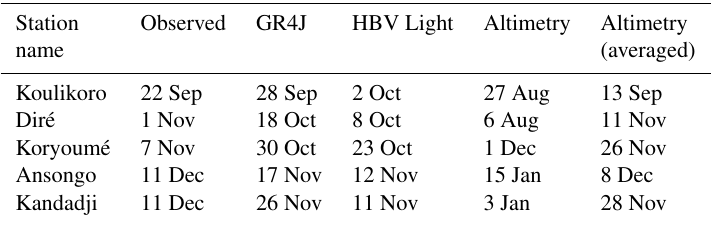
Figure 10. Mean annual hydrographs. The color indicates the station, and the line style indicates the discharge source. Table 2. Dates of maximum flow. Altimetry averaging is done by fitting an annual signal through the points. The points and complete hydrographs can be seen in Fig.